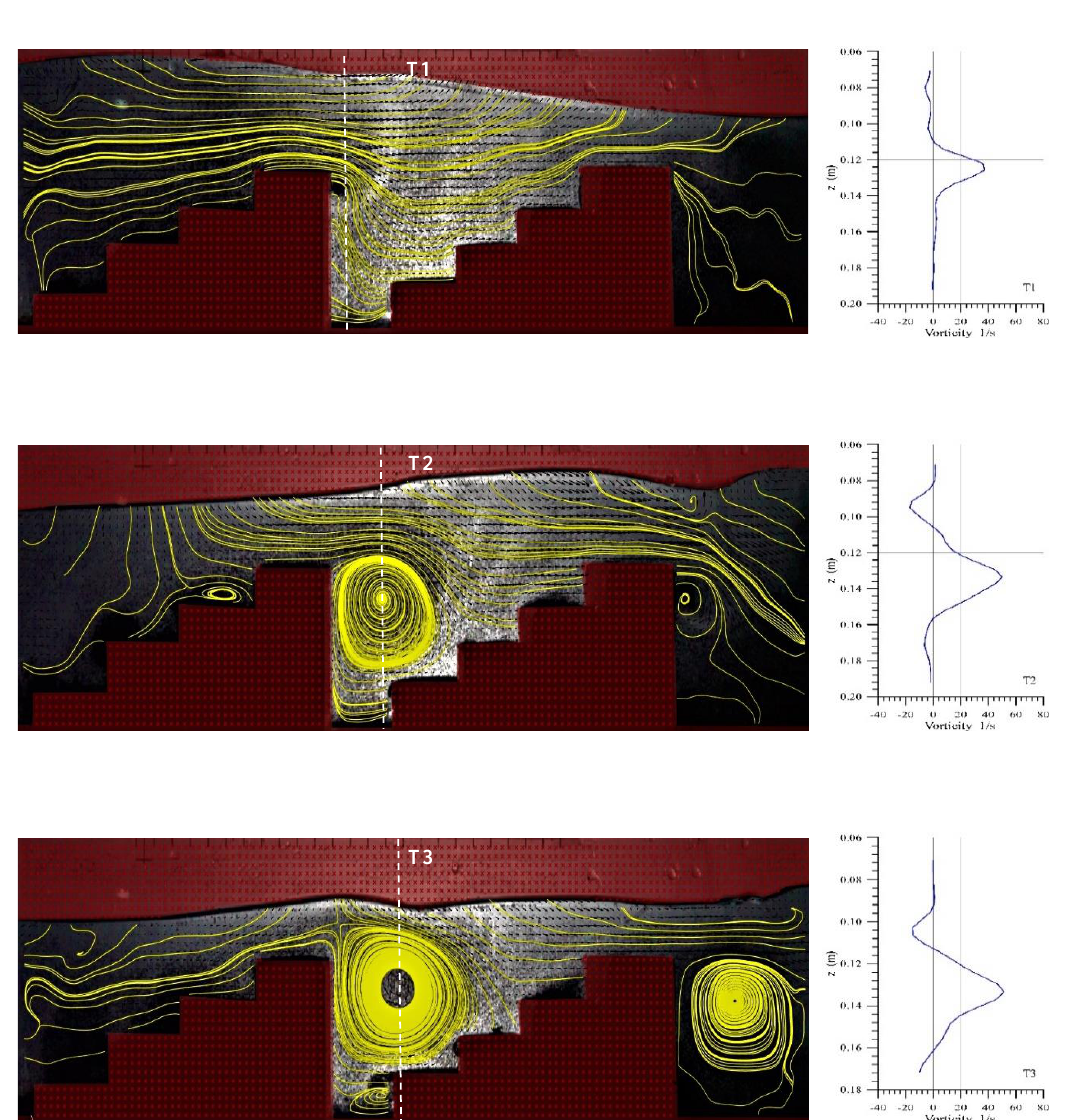
Figure 15. The temporal variation of streamlines and the vorticity distribution along the vertical line of the vortex center induced by a solitary-like wave propagating over a composite set of rectangular submerged breakwaters.